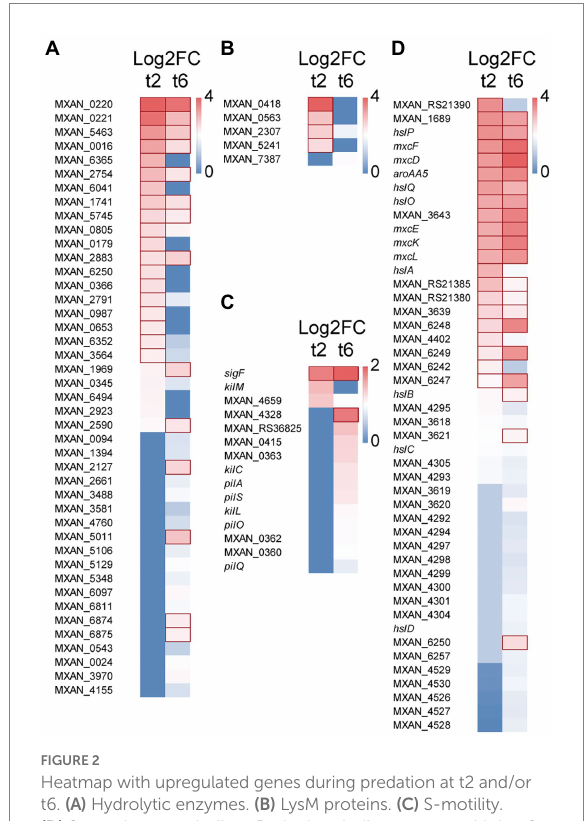
FIGURE 2 Heatmap with upregulated genes during predation at t2 and/or t6. (A) Hydrolytic enzymes. (B) LysM proteins. (C) S-motility. (D) Secondary metabolites. Red edges indicate genes with Log2 Fold Change >